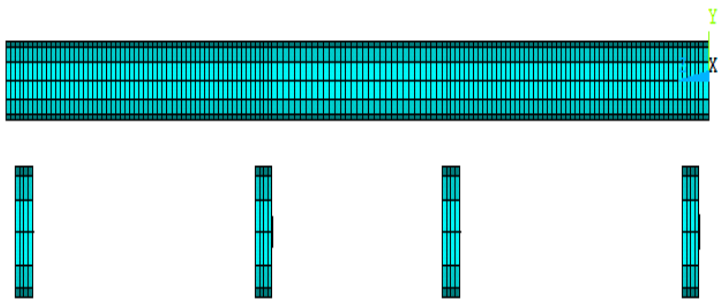
Figure 6. Modeling and meshing of the steel circular hollow specimens.